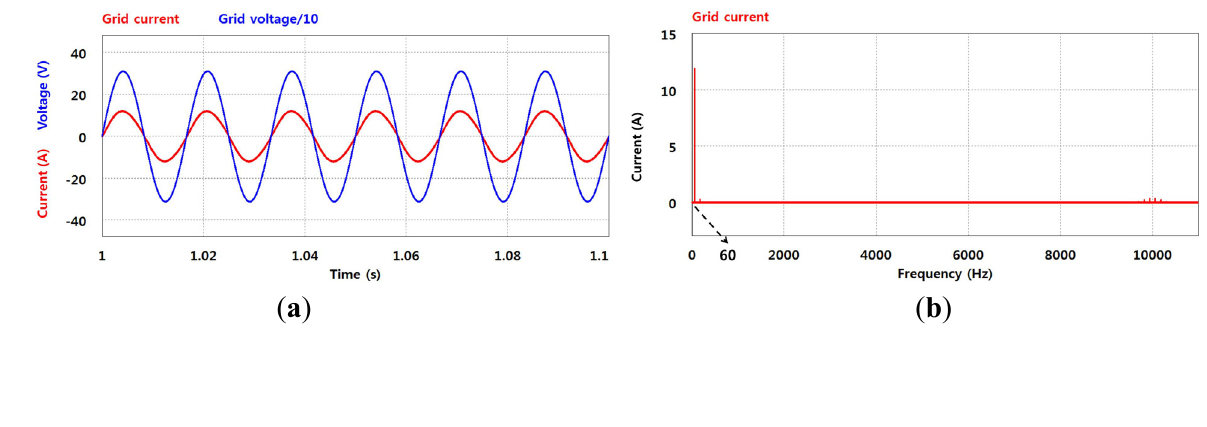
Figure 19. Simulation waveform of the grid current and voltage with compensation. ( a ) Time domain; ( b ) frequency